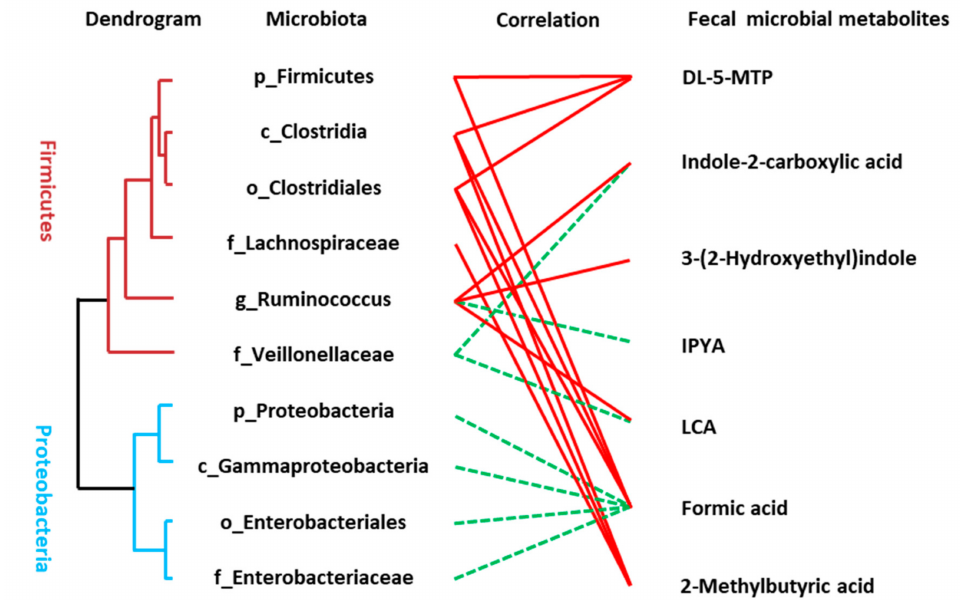
Figure 4. Linkage between altered microbes and differential microbial metabolites of AD patients. Correlation analysis between the altered microbiota and fecal metabolites were conducted using Spearman rank correlation or Pearson correlation analysis (red line means significantly positive correlation and green line means significantly negative correlation). The hierarchical cluster of gut microbiota was achieved based on the correlation coefficient of the relative